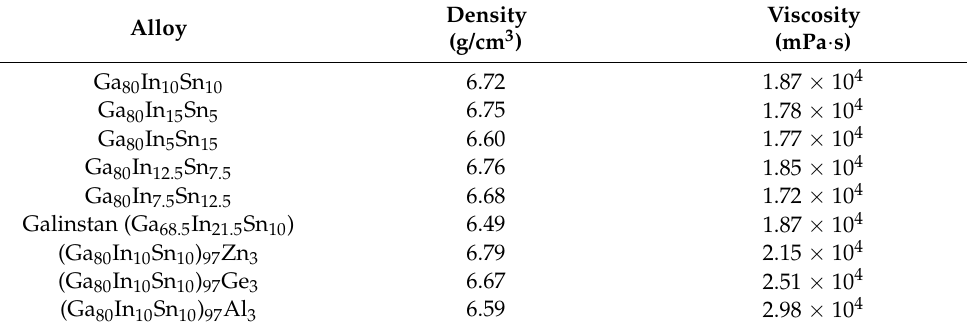
Table 4. The viscosity of gallium-based alloys by rheometer (25 ◦ C, shear rate = 3 1/s). Density Alloy (g/cm 3 )